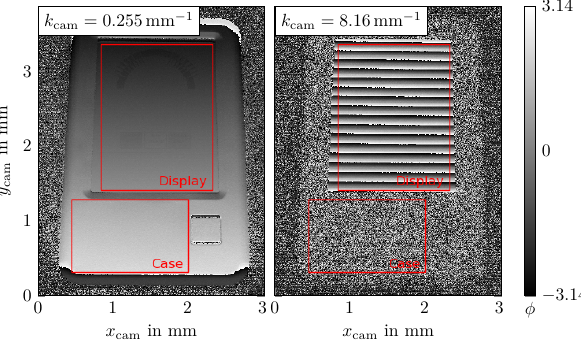
Figure 22. Measurements of φ for different pattern frequencies un- der dark conditions. Measurement noise increases with the pattern frequency, depending on the surface reflectance.